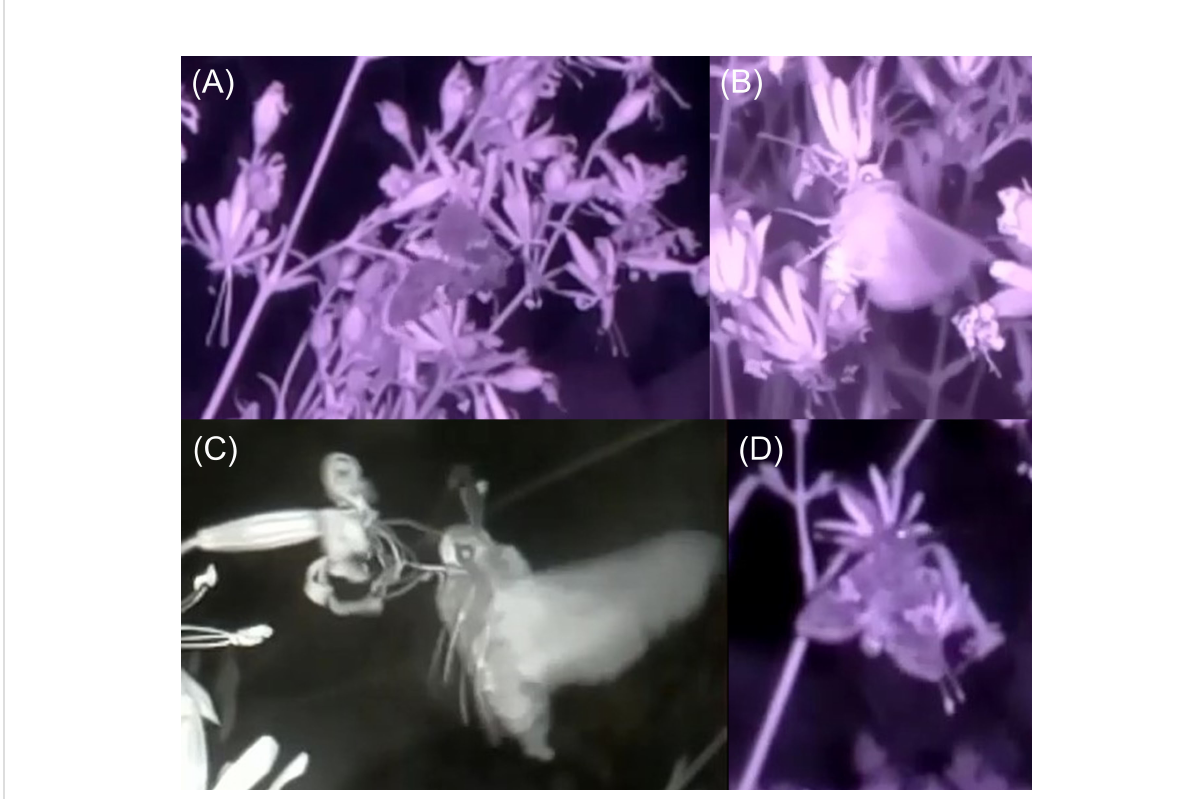
FIGURE 2 Examples of nocturnal pollinators of Silene nutans observed with homemade infrared cameras in 2019 and 2020: (A) Hadena sp., (B) Noctuidae, (C) Proserpinus proserpina , and (D) Hadena albimacula